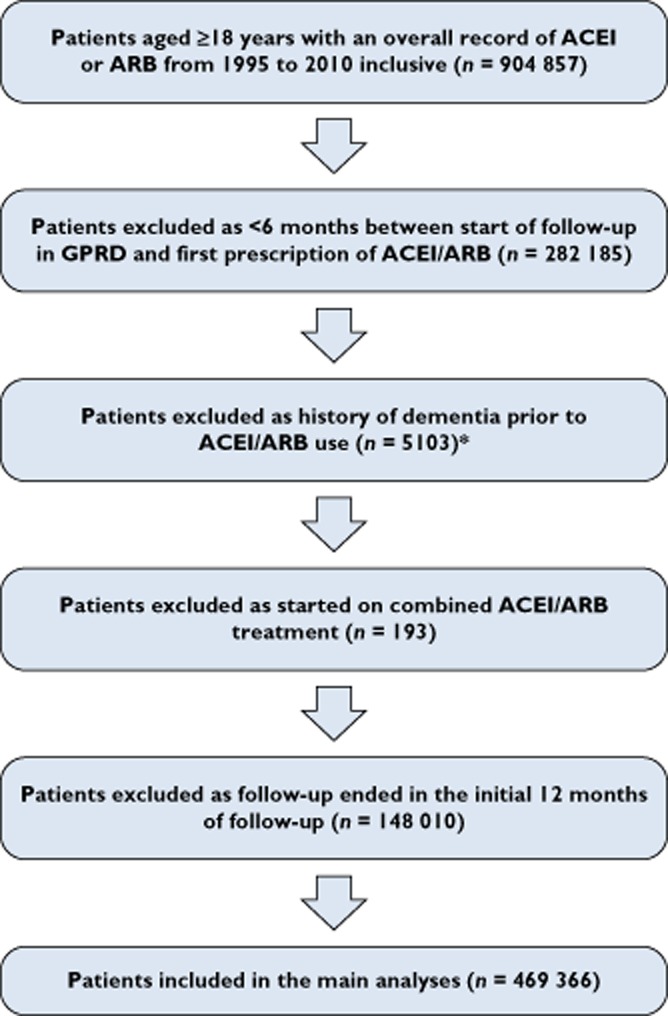
Inclusion and exclusion of study participants. Abbreviations are as in Figure 1. *Individuals with a history of dementia (n = 5103): ACEI users = 4761 (0.84% out of a total of 563 792 ACEI users); ARB users = 339 (0.58% out of a total of 58 684 ARB users); and ACEI+ARB users = 3 (1.53% out of a total of 196 ACEI+ARB users)